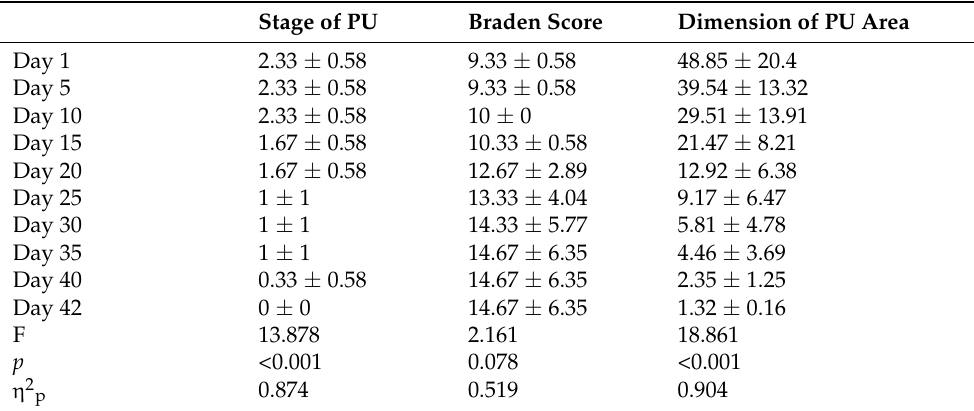
Table 3. Time-based comparisons of stage of PU, Braden score, and dimension of PU area.